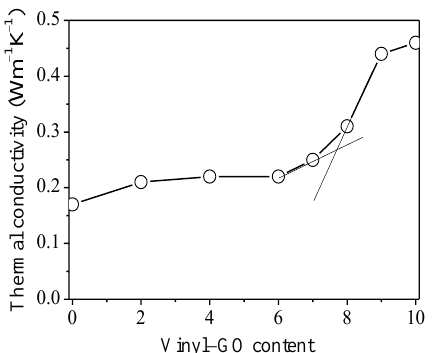
Figure 6. The relation of the thermal conductivity of SR/vinyl-GO nanocomposites with the vinyl- GO content. GO